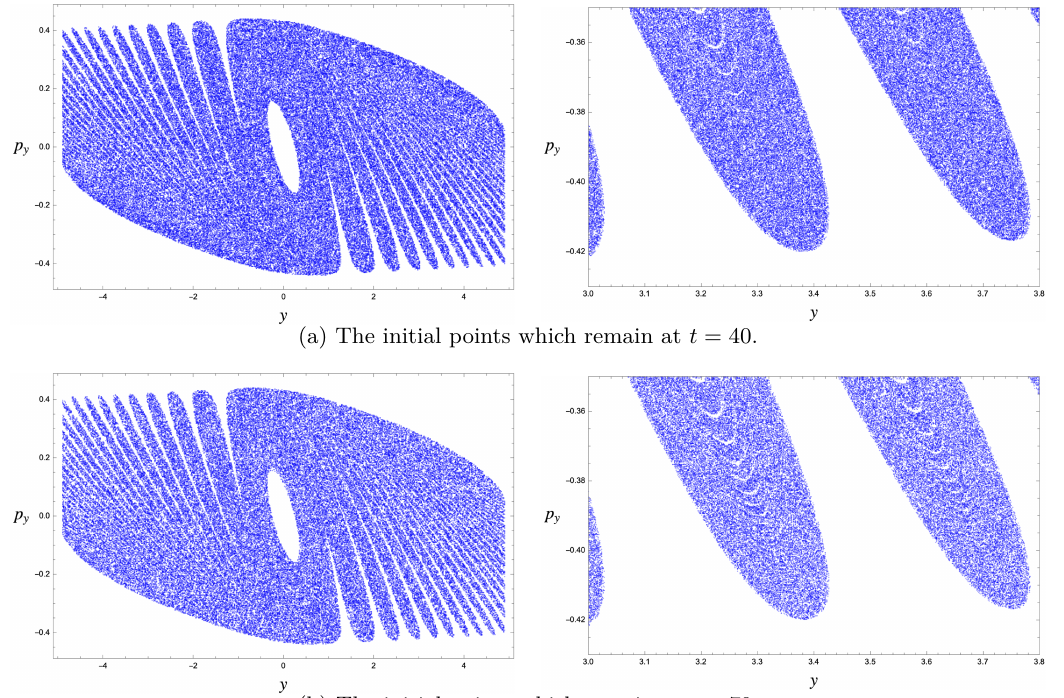
Figure 8 . Initial conditions which remain in the chaotic region B . The figure on the right is a zoomed-in view of the area of 3 . 0 < y < 3 . 8 , − 0 . 043 < p y < − 0 . 35 in the figure on the